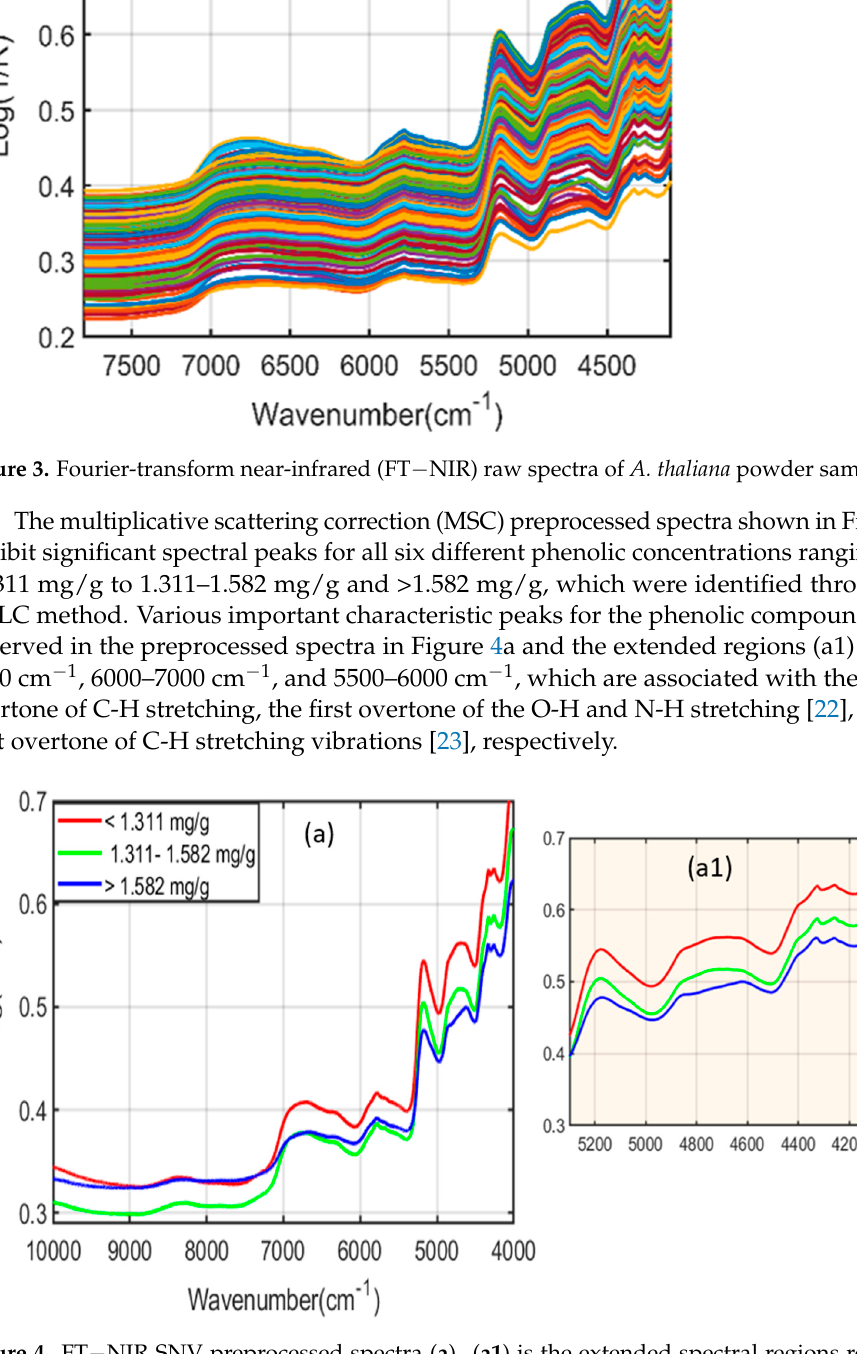
Figure 4. FT − NIR SNV preprocessed spectra ( a ). ( a1 ) is the extended spectral regions related to phenolic compounds.